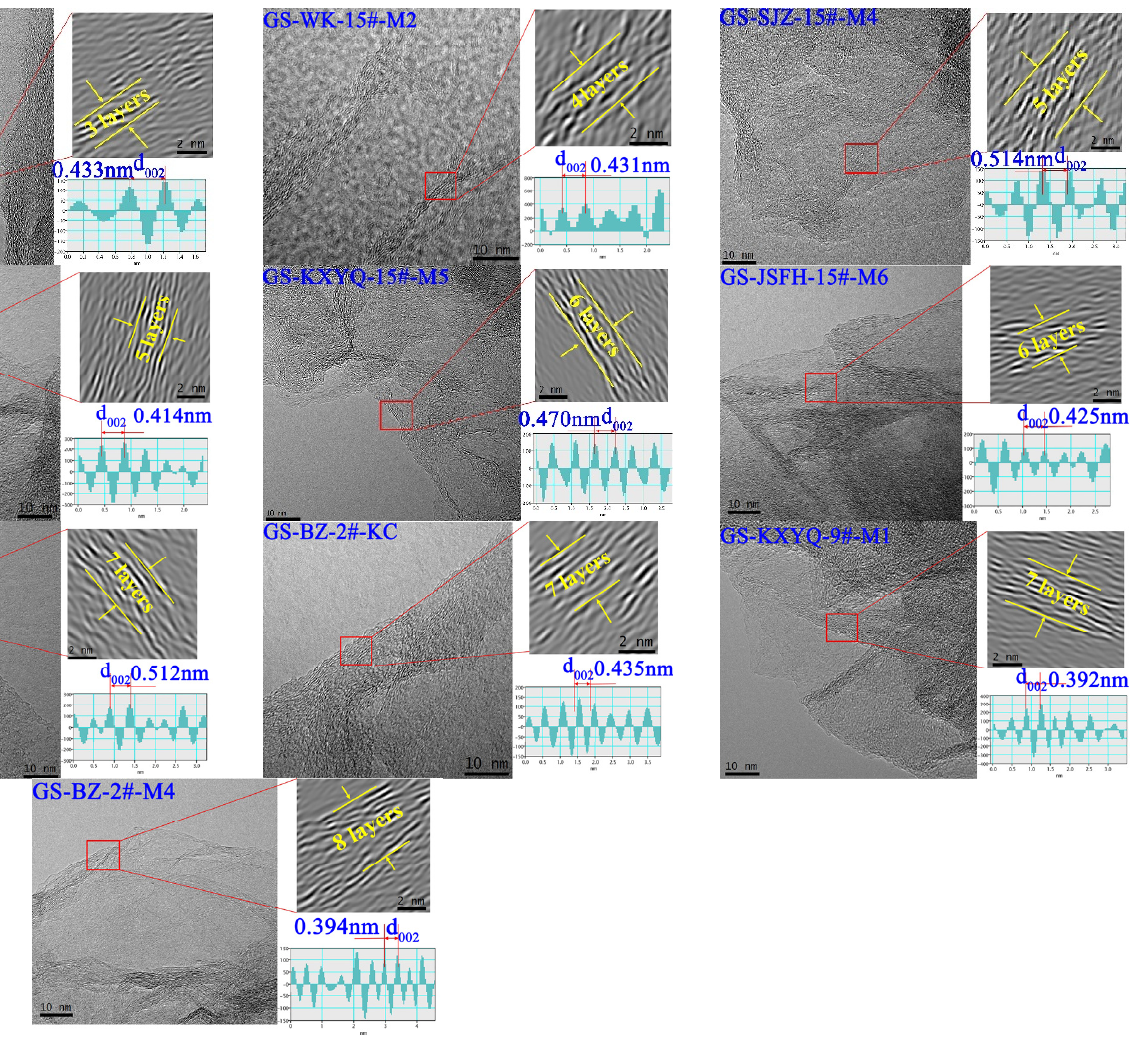
Figure 18. HRTEM images of Qinshui-coal-based graphene.